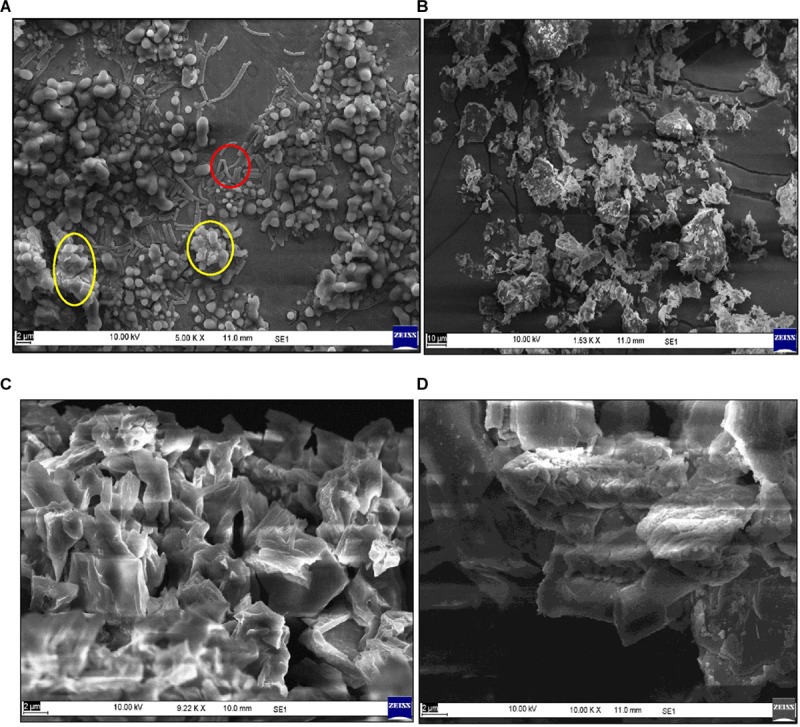
Scanning electron micrographs of (A)
Bacillus sp. TERI VB2 culture broth under optimized conditions. Red color circle depicts bacteria while bioflocculant is encircled in yellow; (B) Kaolin clay particles; (C) purified bioflocculant; and (D) kaolin clay particles agglomerated with purified bioflocculant.